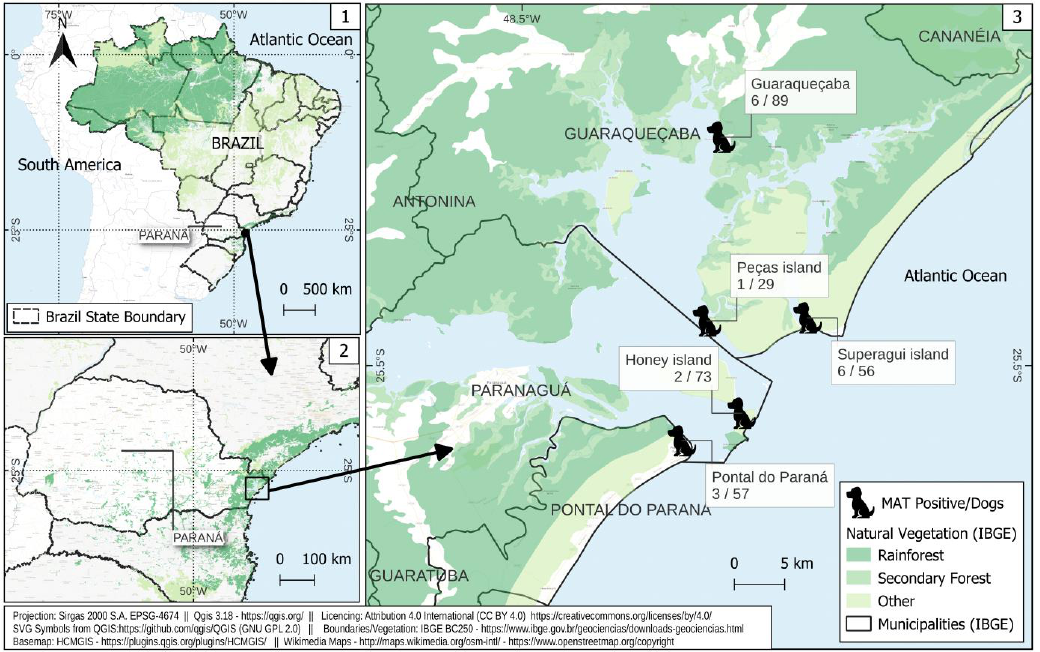
Figure 1. Sampling locations and frequency of anti- Leptospira spp. antibodies in owners and dogs from island and seashore mainland areas of southern Brazil. 1. Map of Brazil; 2. Map of Parana State; 3. Map islands and seashore mainland studied areas.